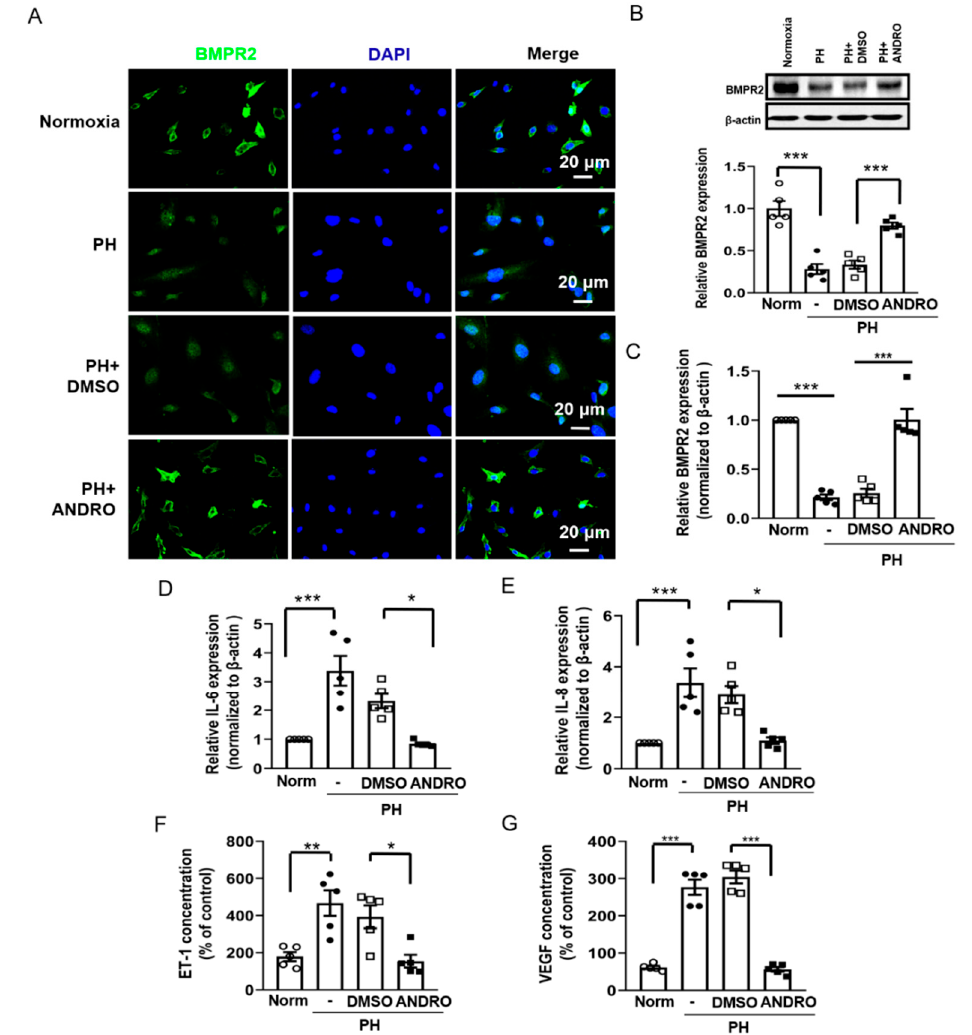
Figure 6. Effect of ANDRO on NF- κ B-related signaling cascade in PH-PASMCs. ( A – C ) Immunofluorescence staining ( A ), Western blots ( B ) and qRT-PCR ( C ) showing the effect of ANDRO on the expression of BMPR2 in PH-PASMCs. ( D , E ) QRT-PCR analysis showing that ANDRO significantly decreased IL-6 ( D ) and IL-8 ( E ) expression in PH-PASMCs. ( F , G ) ELISA assay showing that AN- DRO significantly decreased ET-1 ( F ) and VEGF ( G ) expression in PH-PASMC. Data represent mean ± SEM. n = 5. * p < 0.05, ** p < 0.01, *** p <